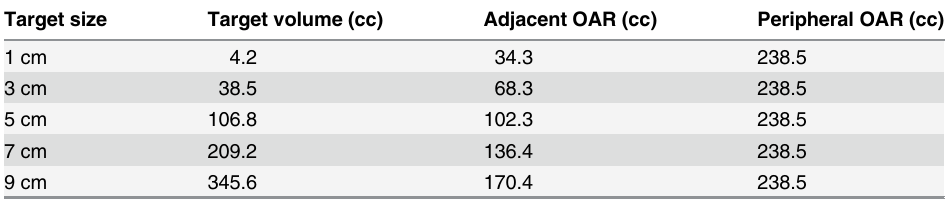
Table 1. Volumes of the target, adjacent organ at risk (OAR) and peripheral OAR with respect to target size. Target